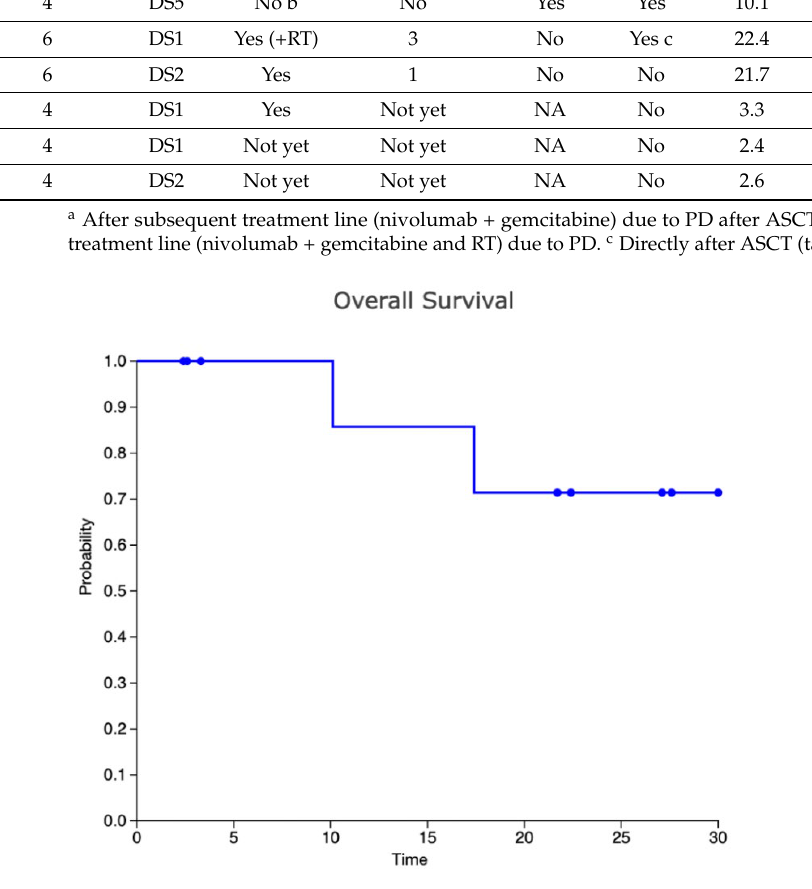
Figure 1. Kaplan–Meier curve for OS. Three patients (30%) experienced four adverse events (AEs) during the treatment with pembrolizumab and BV: one case of infusion-related reaction, neutropenia, polyarthritis and hyperthyroidism, respectively, all classified as grade 3 events. Polyarthritis was managed with pembrolizumab discontinuation and systemic corticosteroids treatment, hyperthyroidism with pembrolizumab discontinuation only. Two patients (33%)